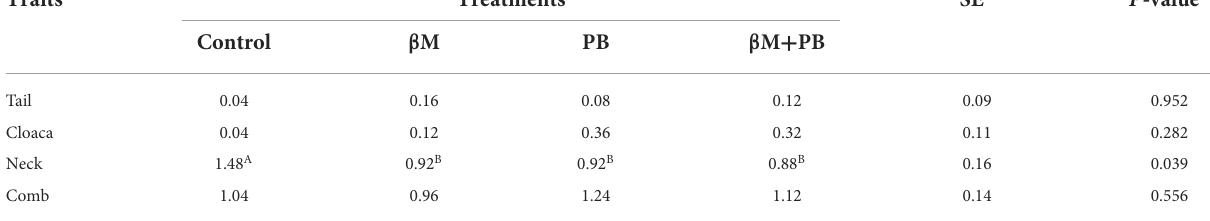
TABLE 6 Lesion score observed in laying hens fed β -mannanase and/or probiotics¹.